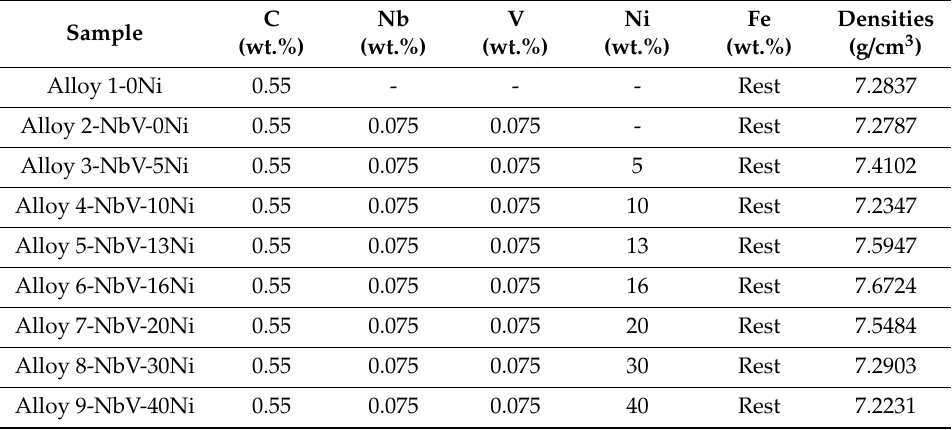
Figure 1. SEM micrographs of powders; ( a ) graphite, ( b ) iron, ( c ) niobium, ( d ) vanadium and ( e ) nickel. Table 1. Chemical components of powder metallurgy